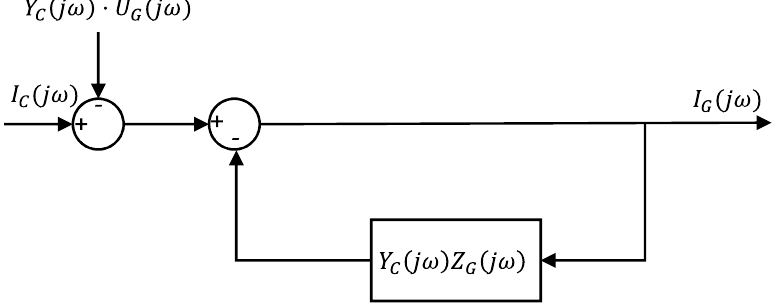
Figure 2. Equivalent circuit diagram represented as feedback